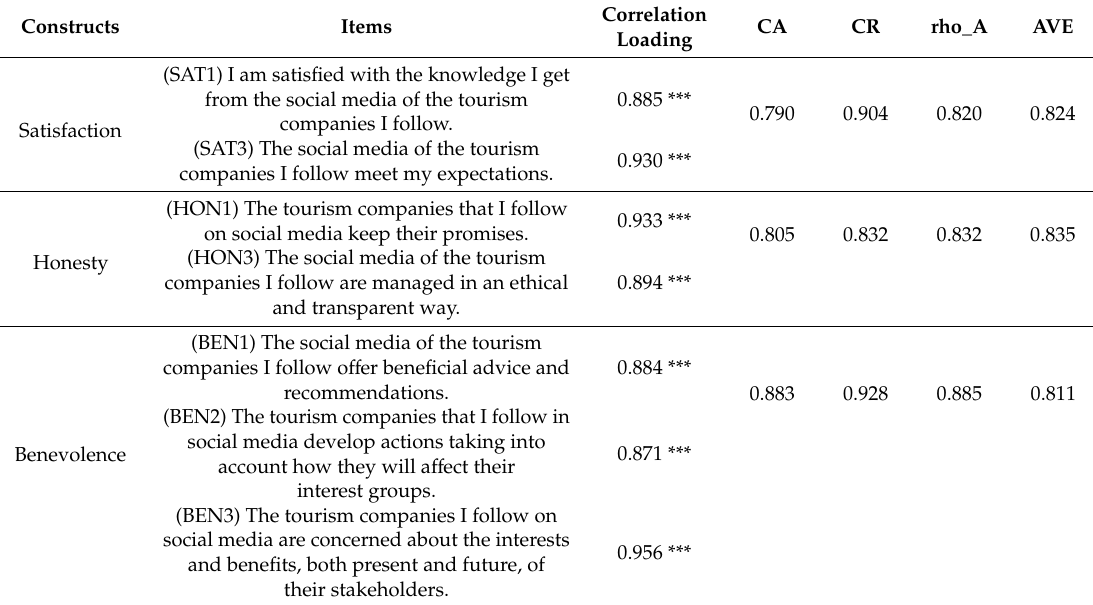
Table 2. Measurement items first